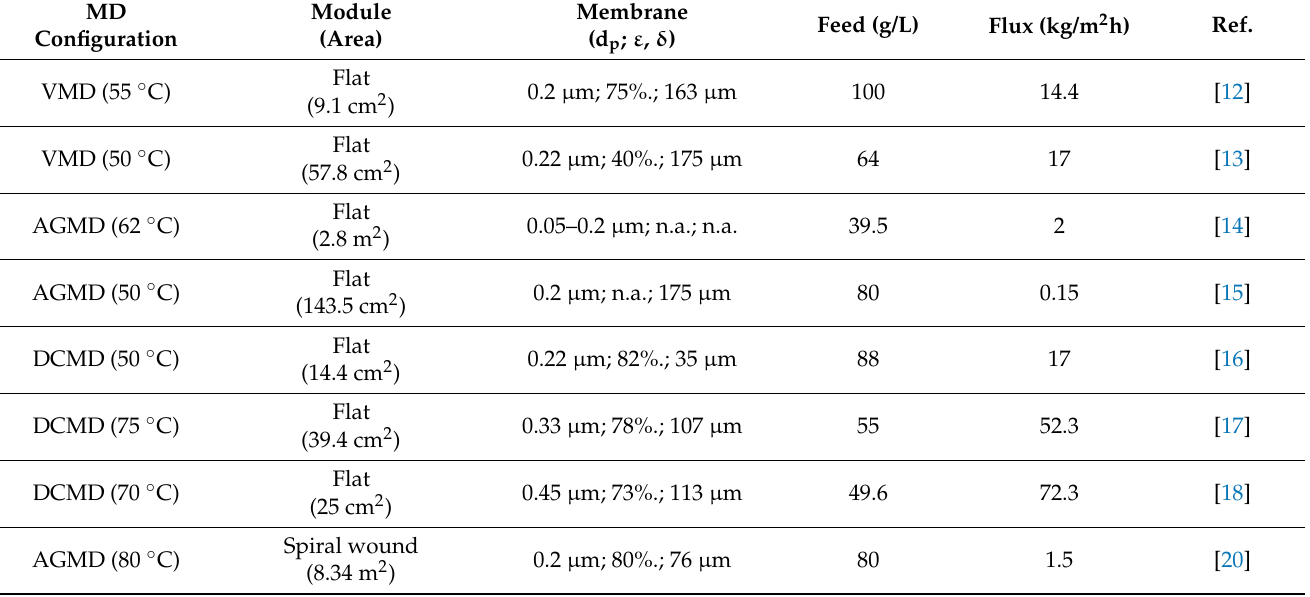
Table 3. Main literature data for the treatment of RO brines by